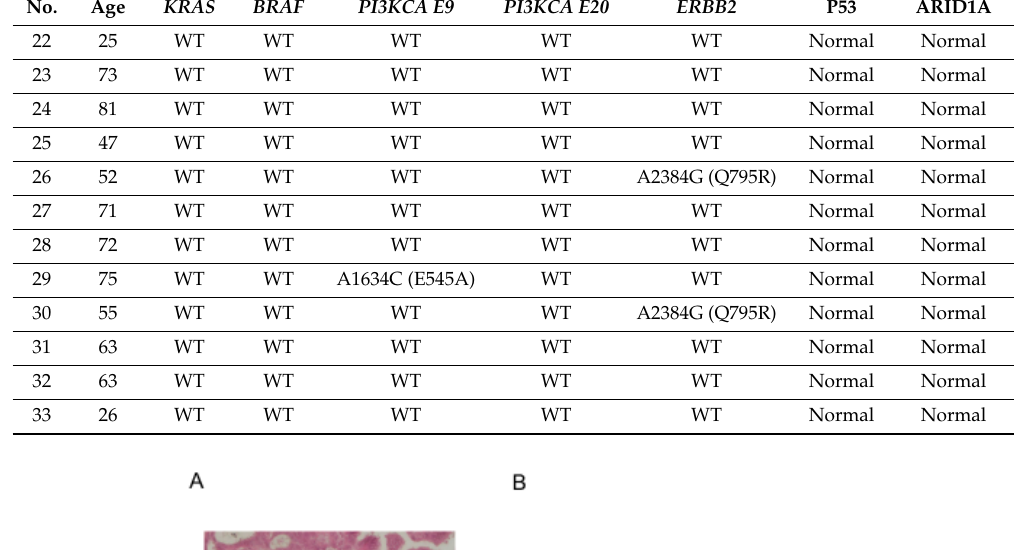
Table 3. Mutation and immunohistochemical analysis of serous cystadenoma (SCA). WT; Wild Type. No.